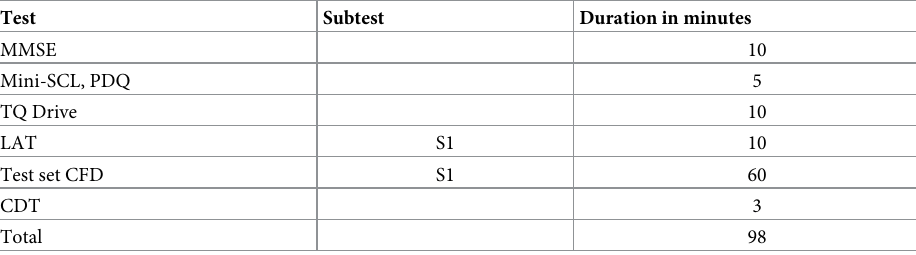
Table 1. Schedule of the neuropsychological